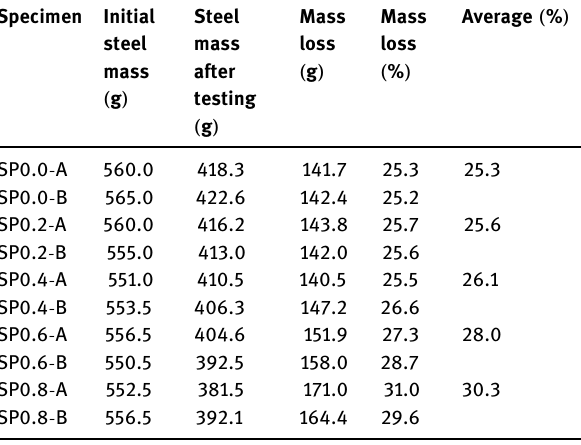
Table 5: Mass loss of corroded steel bars Specimen Initial